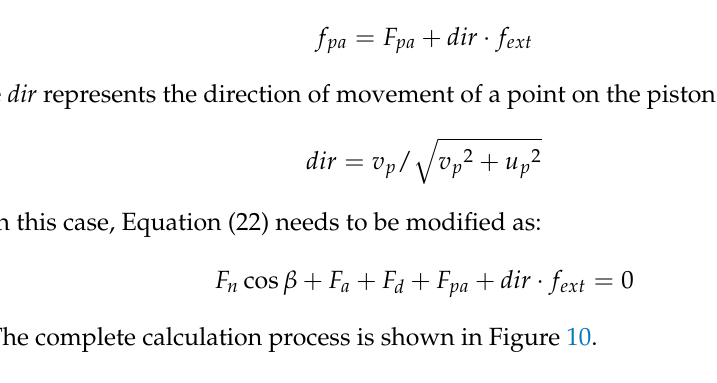
Figure 10. Calculation process.